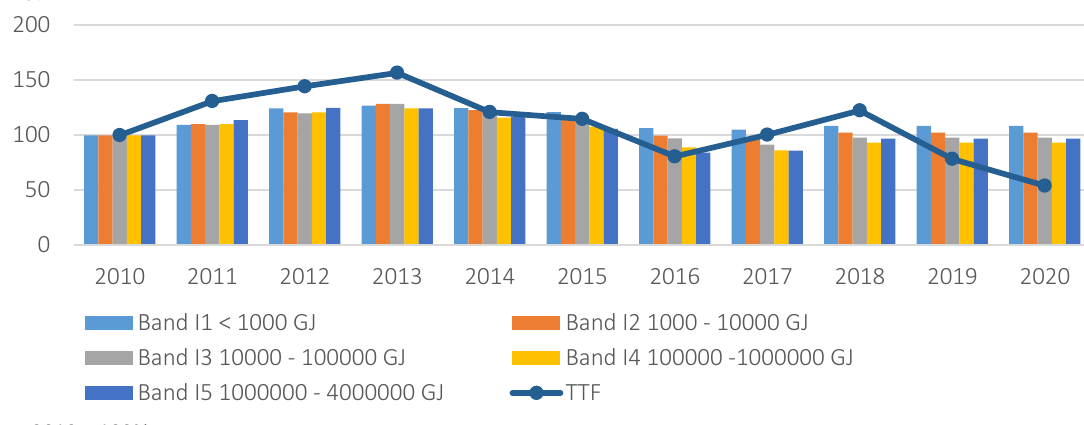
Figure 4. Change in the tariff for natural gas by category of industrial enterprises, including taxation in the EER countries